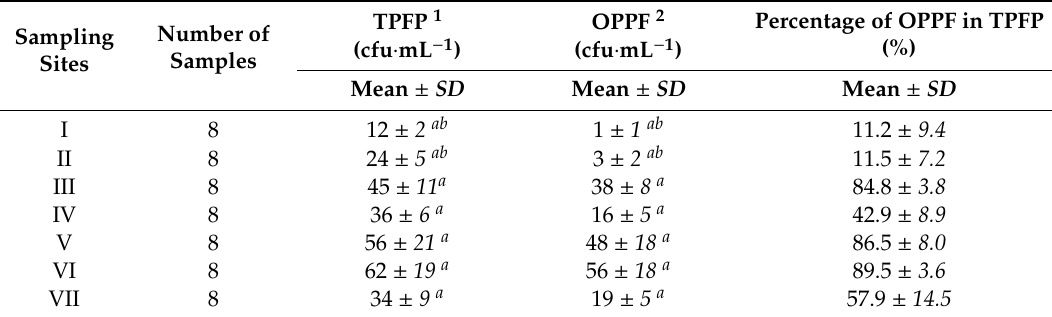
1 total Pseudomonas fluorescens population; 2 opportunistic pathogens Pseudomonas fluorescens ; a statistically significant di ff erences ( p ≤ 0.05) in the Kruskal-Wallis test ( N = 56); b statistically significant di ff erences ( p ≤ 0.05) in Student’s t -test ( N = 8, df =